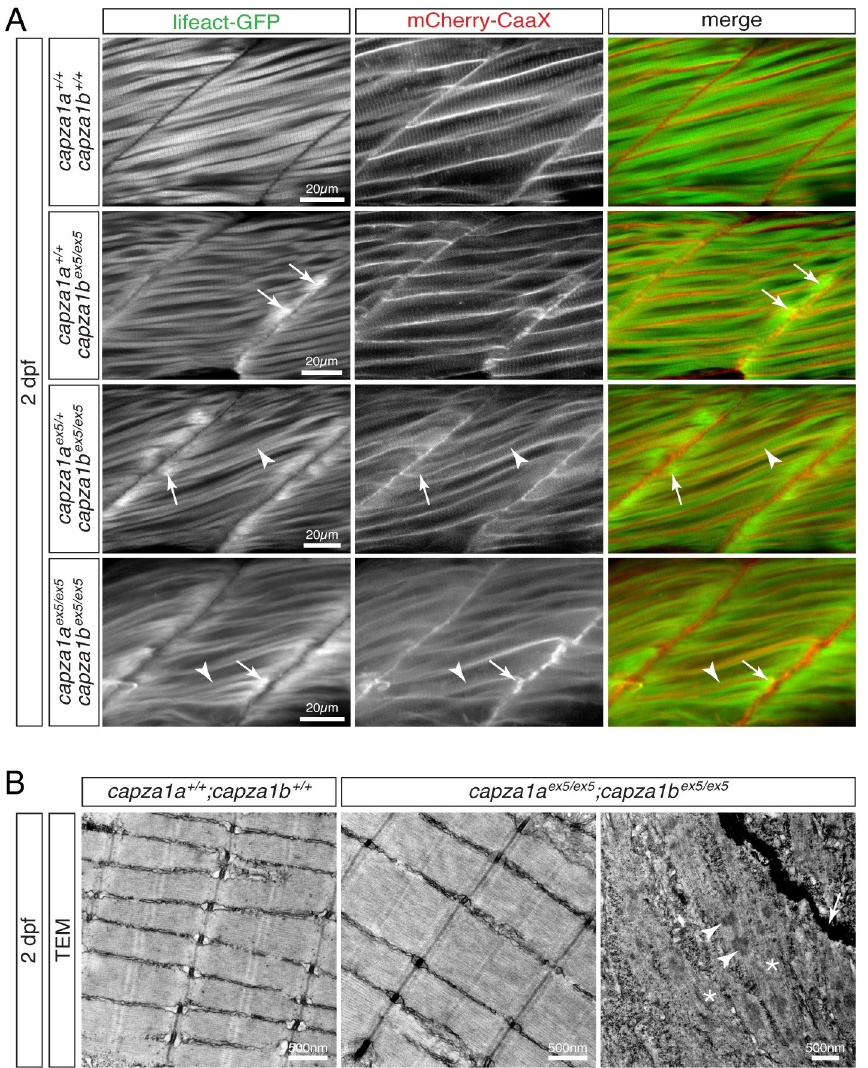
Fig 6. Residual sarcomeres assemble within capza1a and capza1b depleted zebrafish. (A) At 2 dpf, Lifeact-GFP (green) and mCherry-CaaX (red) highlighted the sarcomere organisation and myofibril striation within muscle fibres of WT siblings. In two out of four analysed capza1b ex5 homozygotes, thin filament deposits (arrows) were detected at the peripheral ends of some fibres. Although myofibril striation (arrowheads) was detected in capza1b ex5 homozygotes that were hetero- or homozygous for capza1a ex5 , thin filament deposits (arrows) were frequently located at the peripheral myofiber ends. (B) At 2 dpf, highly organised sarcomeres were found on transmission electron micrographs of siblings and capza1a ex5 ; capza1b ex5 compound homozygotes. However, electron-dense aggregates with a lattice structure (arrowheads) and filament deposits (star) were present close to the myosepta (arrow) in the compound homozygotes. Scale bar sizes are